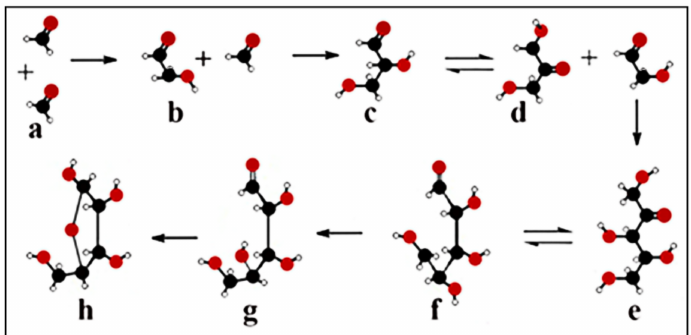
Figure 1. β - D -ribose synthesis in the formose reaction . Two formaldehyde molecules ( a ) condensed to glycolaldehyde ( b ). The subsequent aldol condensation is forming glyceraldehyde ( c ), which undergoes a ketose-aldose isomerization ( d ). Glyceraldehyde reacts with glycolaldehyde to bring about pentulose ( e ). Selective isomerization takes place between pentulose ( e ) and D -ribose ( f ), favoring the nucleophilic addition reaction of D -ribose ( g ) and ring formation to β - D -ribose ( h ). It deserves to be mentioned in this context that the formose reaction does not deliver D -ribose enantioselectively, but only racemic ribose. D -ribose depicted here (for clarity